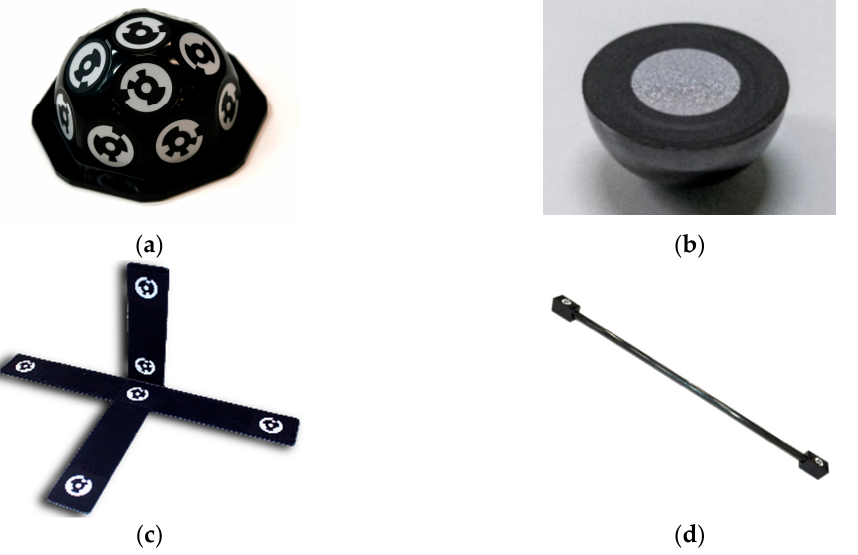
Figure 3. ( a ) The igloo-shaped auxiliary element with coded markers. At the bottom, there are three magnets for attaching the element to ferromagnetic workpieces. ( b ) A retroreflective target on a hemisphere for use with the nests on the reference wall (target diameter: 20 mm). ( c ) Cross-point providing the coordinate system’s origin. ( d ) Scale bars with coded markers ensure the correct scale of the measurement